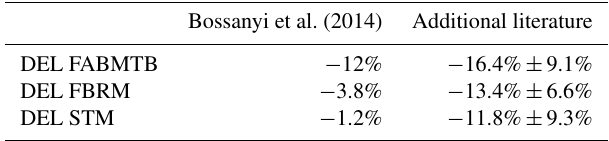
Table 3. LAC-enabled load reductions from Bossanyi et al. (2014) compared to other